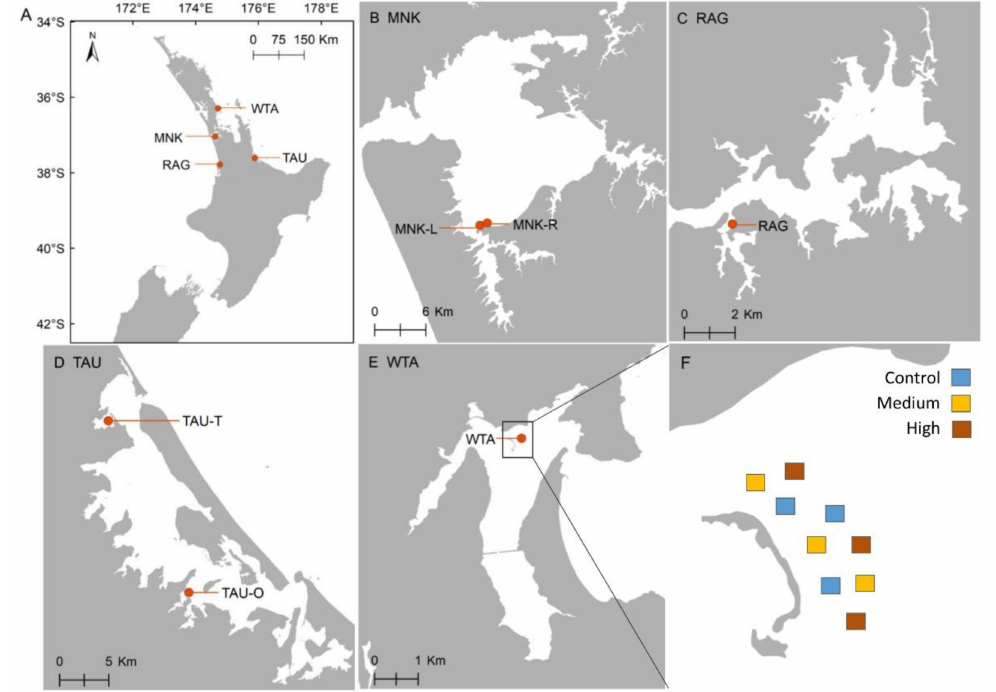
Figure 1. Location of the four estuaries within the North Island of New Zealand ( A ), and sampling sites within ( B ) Manukau (MNK), ( C ) Raglan (RAG), ( D ) Tauranga (TAU) and ( E ) Whangateau (WTA) estuaries. Panel ( F ) depicts an example of the allocation of nutrient enrichment treatments (control = 0, medium = 150 and high = 600 g N m − 2 ) to experimental plots within the Whangateau estuary. For site-specific GPS locations see Table